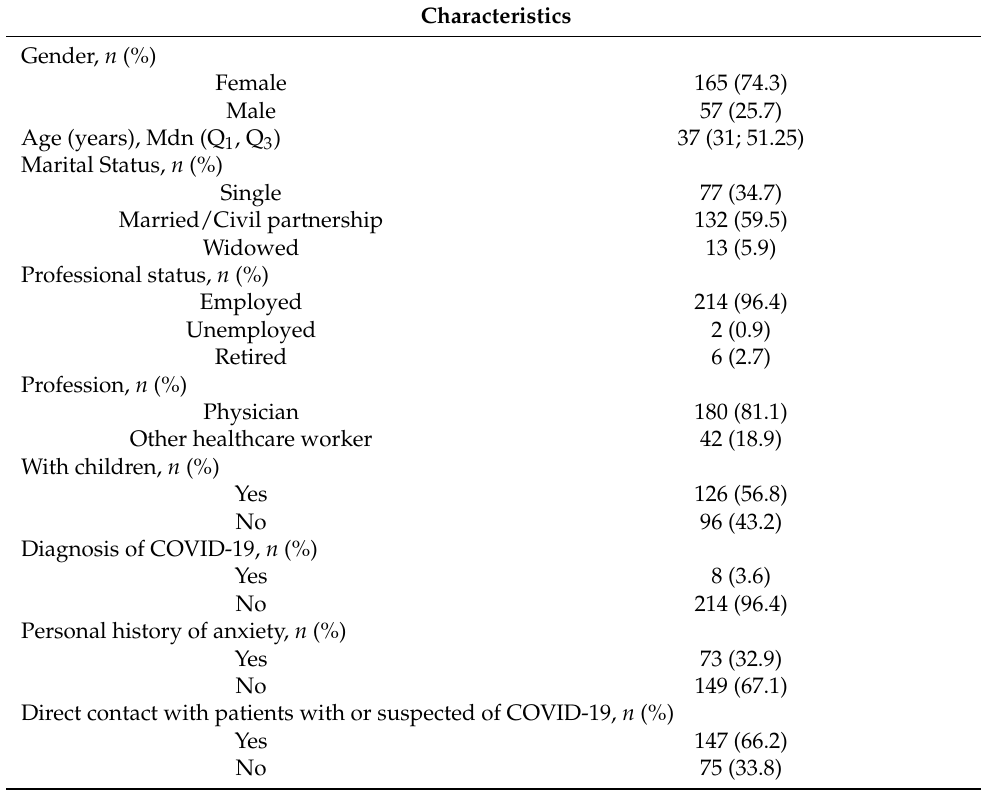
Table 1. Socio-demographic and health data ( n =